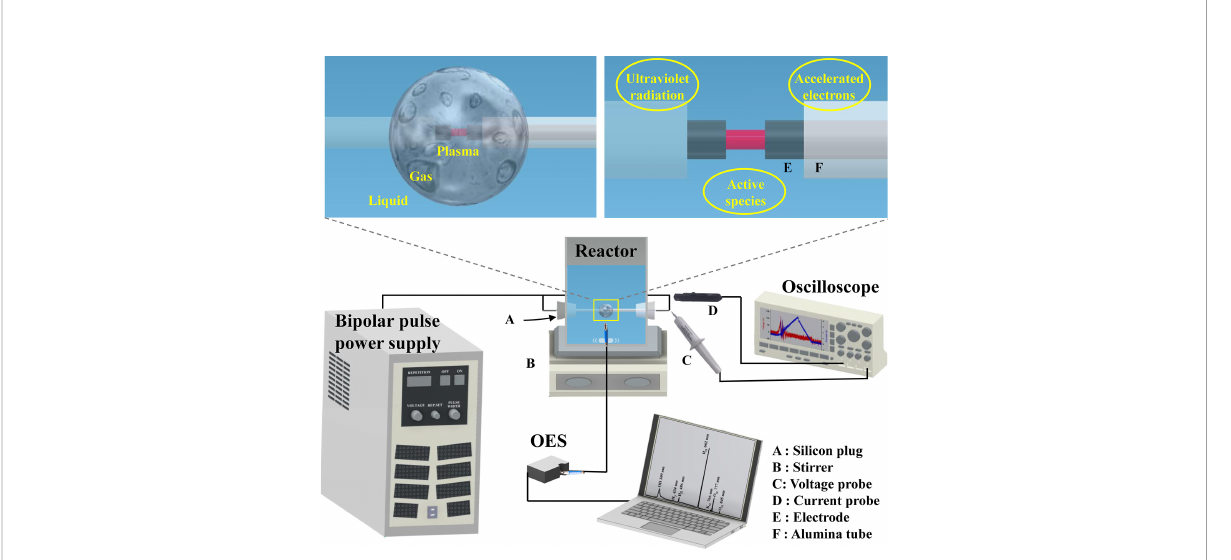
FIGURE 1 Schematic illustration of apparatus, plasma reaction fi eld, and products of liquid phase plasma. (A) silicon plug, (B) stirrer, (C) voltage probe, (D) current probe, (E) electrode, (F) alumina